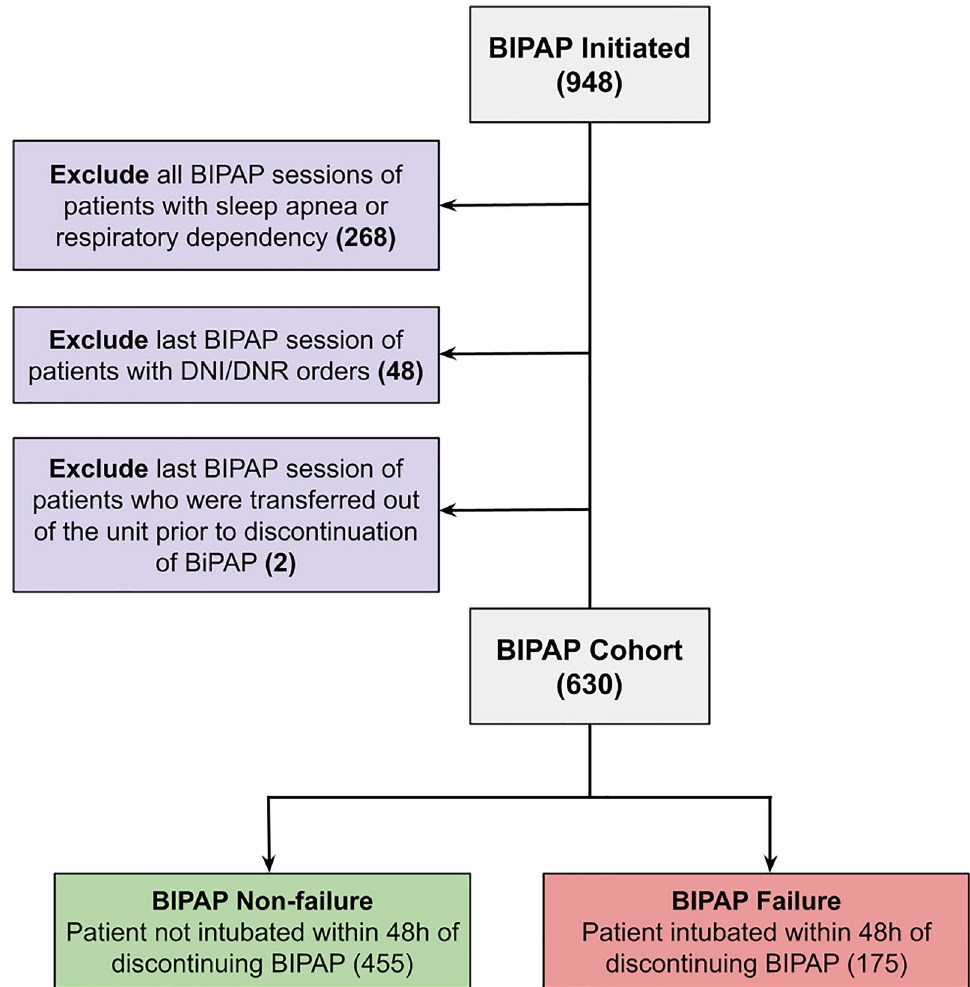
Figure 1. Cohort selection process. The dataset contained 948 instances where BIPAP was initiated. All BIPAP sessions of a patient with a previous diagnosis of respirator/ventilator dependence or sleep apnea were excluded. The last BIPAP session of any patient with a DNI/DNR order or who was transferred out of the unit prior to the BIPAP being discontinued was excluded. BIPAP sessions that resulted in intubation within 48 h of BIPAP discontinuation were considered BIPAP